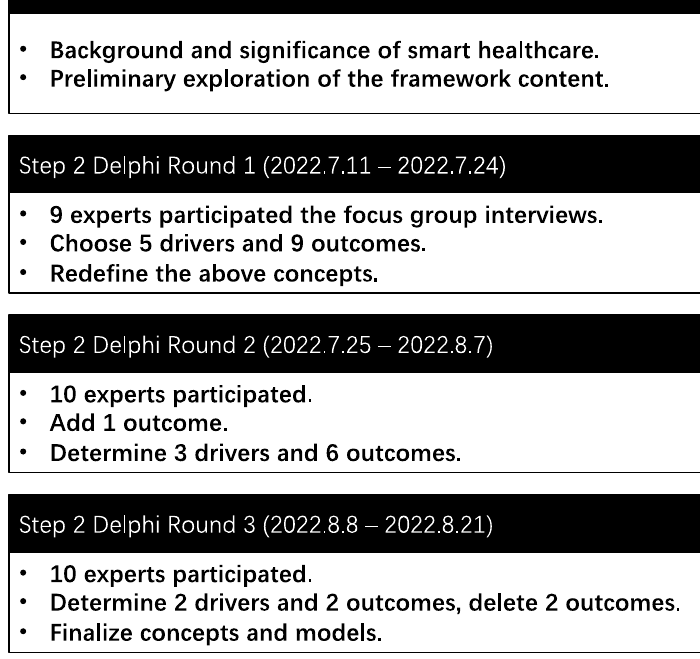
Figure 2. Overall process of factor development for smart health.